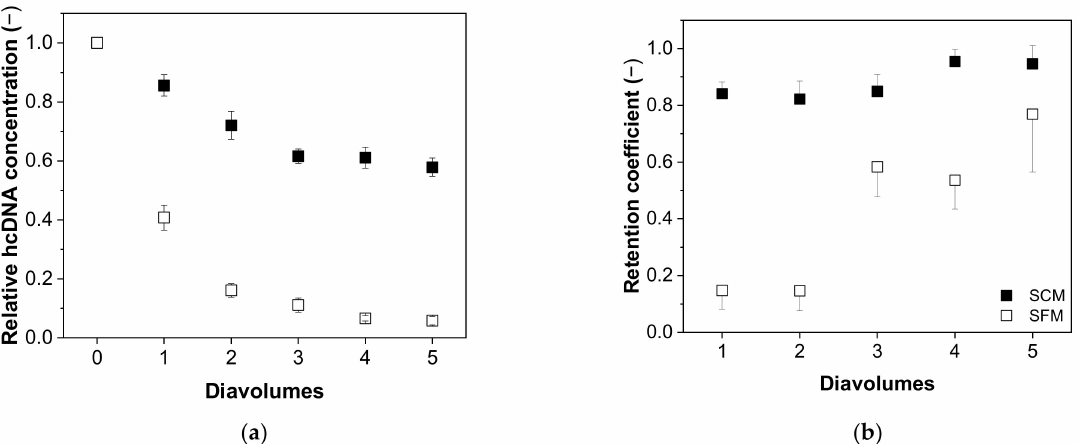
Figure 7. The correlation between the number of diavolumes and ( a ) the relative concentration of hcDNA and ( b ) the retention coefficient for hcDNA during the purification of MV by UF/DF. Data are means ± SEM (n = 5) [37].